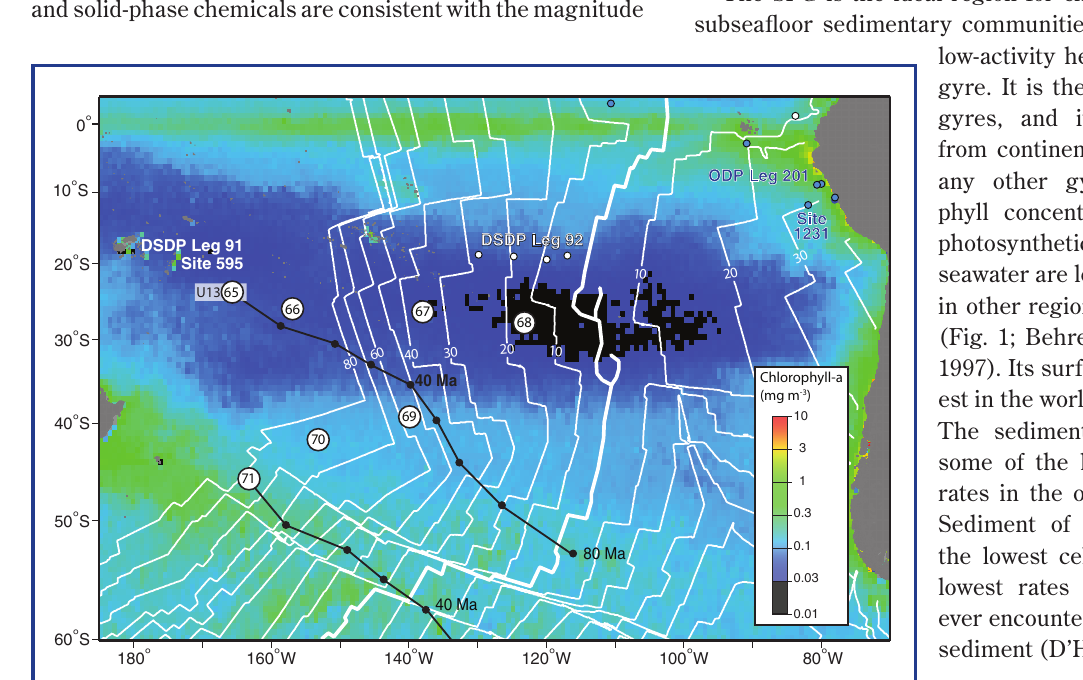
Figure 1. Map of annual chlorophyll-a (Chl-a) concentrations overlain by Exp. 329 site locations (white circles: U1365, U1366, U1367, U1368, U1369, U1370, and U1371). White lines indicate basement age in 10-m.y. increments. Black lines indicate site positions over geologic